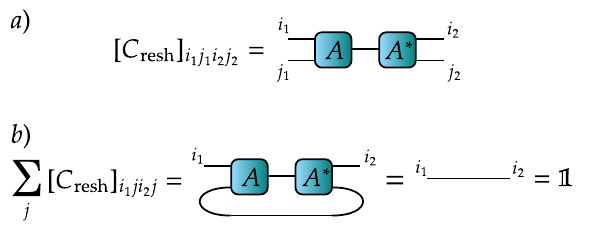
Figure 2: a) Decomposition of a Choi matrix into A and A † . b) Diagrammatic repre- sentation of the isometric property of A .